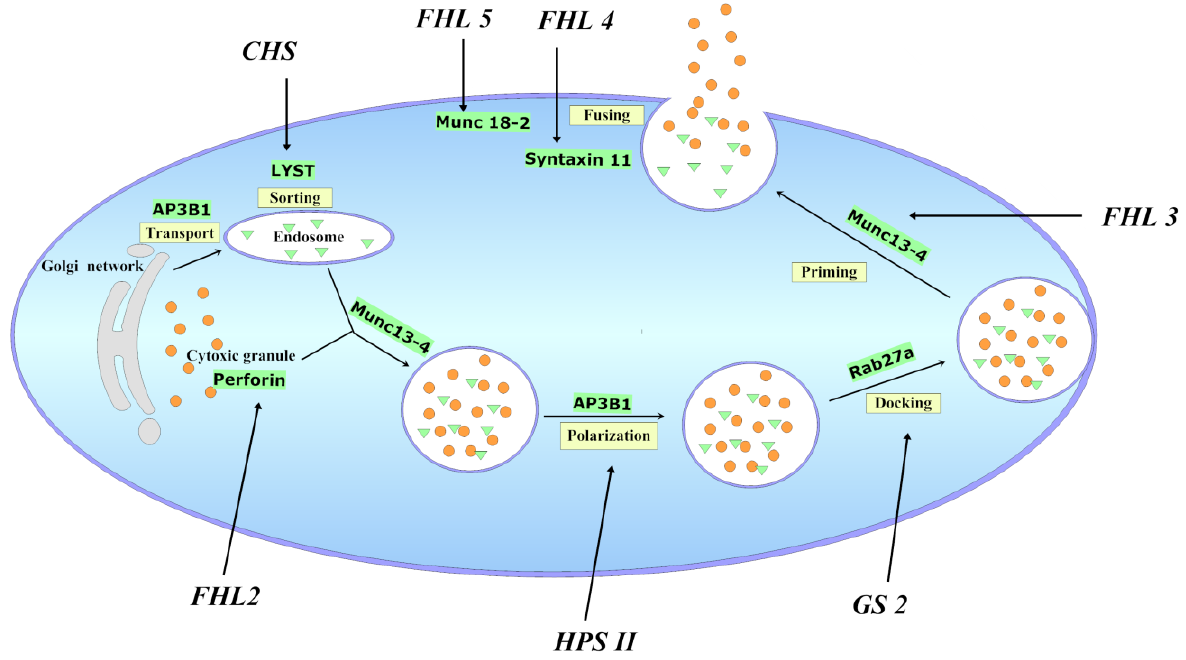
FIGURE 1. The schematic diagram of HLHs and their defective genes. Following T-cell receptor (TCR) stimulation, granzymes and other proteins are secreted from the Golgi network, transported to and sorted in endosomes, which then coalesce with perforin-containing granules to form mature cytotoxic granules. The granules then polarize to the IS and dock at the plasma membrane through the Rab27a. Docked granules are then primed by Munc13-4, which triggers SNARE-mediated membrane fusion. The membrane fusion is exerted by syntaxin 11 and Munc18-2. Impairment of any step in the above process may result in the deficiency of cytotoxic function in NK cells and CTLs and cause